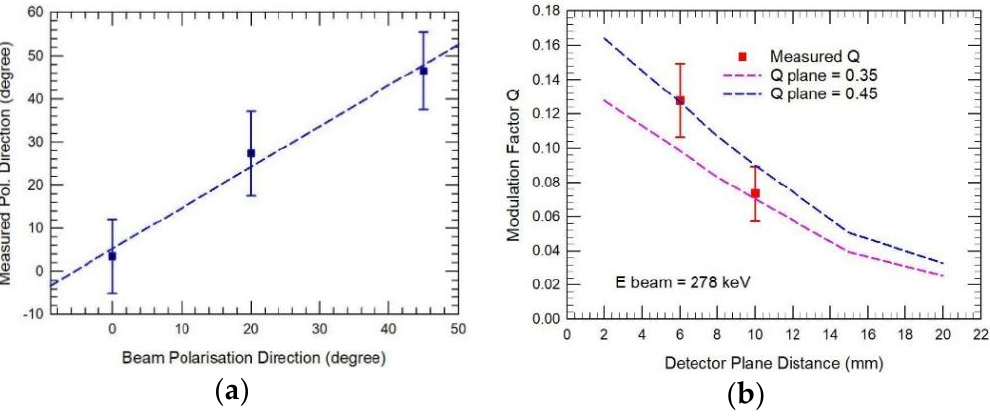
Figure 11. ( a ) Measured polarization plane direction for a 278 (99% polarized) keV beam as a function of the effective ESRF beam polarization angle; and, ( b ) The modulation factor Q 100 measured for 278 keV photons at two different distances between the pixel detector planes (square symbols) as compared with an estimate of the expected modulation factor Q 100 over the entire distance range of the Compton-PolCA system. The two dashed curves give the modulation factor Q expected for 300 keV polarized photons assuming two different realistic values for the intrinsic modulation factor Q 100 of the detector pixel plane ( Q plane).